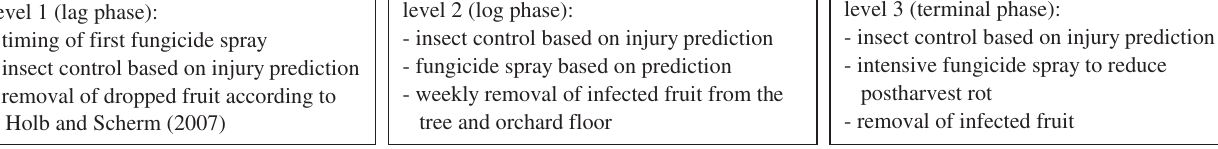
Figure 3 A brown rot forecasting and management strategy (BRFMS) against Monilinia fructigena for organic apple orchards. Explanations: AR6 model: autoregressive model with six autoregressive parameters, AUDPC : area under the disease progress curve (%-days) AUDPC area under the disease progress curve (%-days),